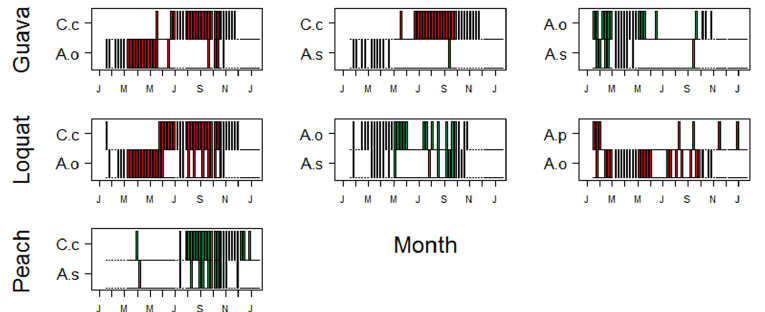
Fig 5. Co-occurrence pattern based on presence-absence data of significantly segregated (red panels) and aggregated (green panels) pairs of tephritid fruit flies sampled in 3 orchards in the year 2003. Abbreviations as in Fig